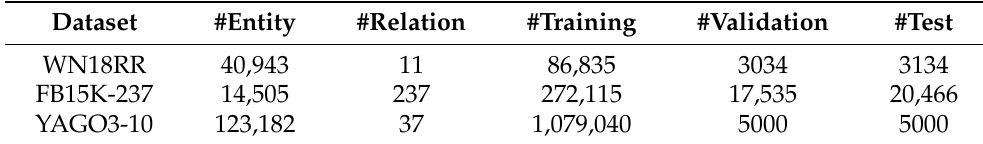
Table 1. The number of entities, relations and observed triples in each split for four benchmarks.